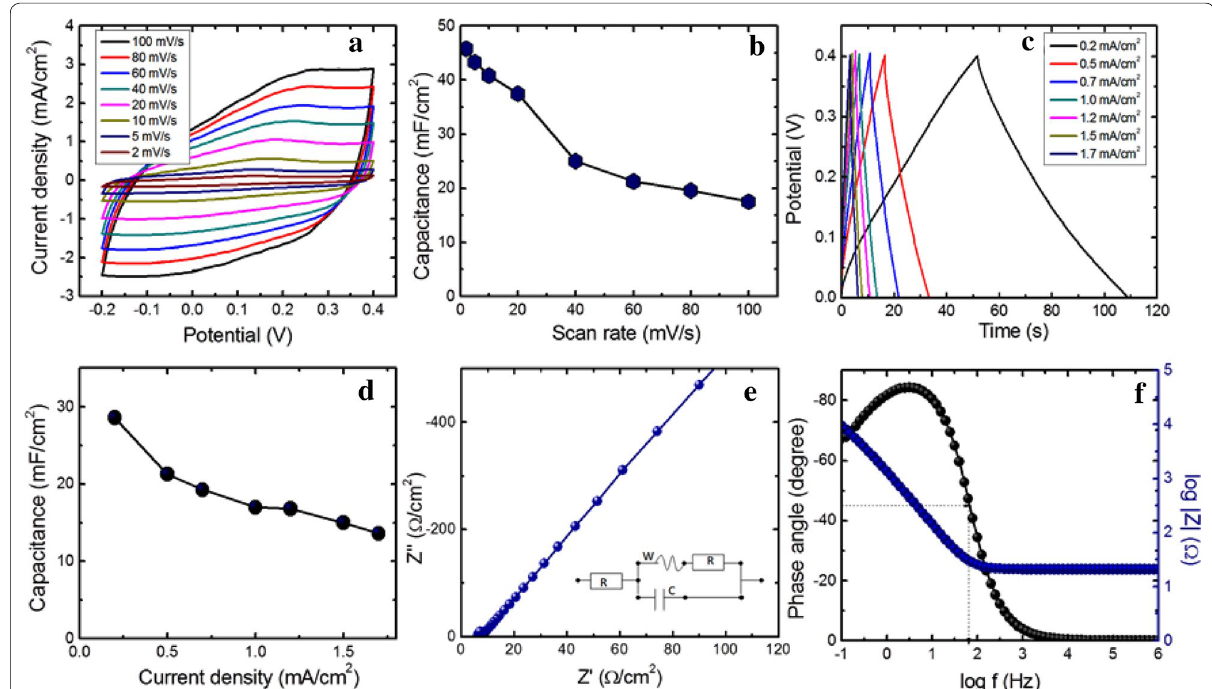
Fig. 6 a Cyclic voltammograms of the 1%/VS 2 electrode recorded at different scan rates ranging from 2 to 100 mV/s scan rate. b Areal capacitance of the 1%/VS 2 electrode as a function of scan rates. c The charge/discharge profiles of the 1%/VS 2 electrode at various current densities recorded in the 0 to 0.4 V vs Ag/AgCl potential window. d The capacitances of the 1%/VS 2 electrode calculated at a current density ranging from 0.2 to 1.7 mA/ cm 2 . e The Nyquist plot of the 1%/VS 2 electrode and the inset shows the equivalent circuit used to fit the impedance data. f The Bode phase and magnitude plot for the 1%/VS 2